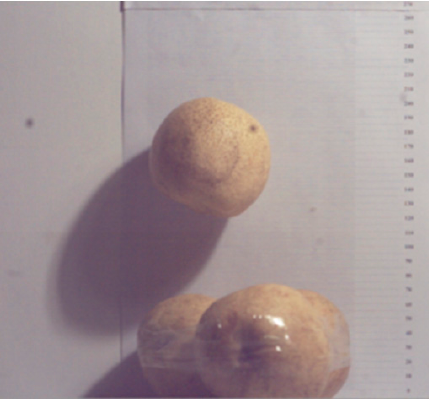
Figure 7. Calibration experiment of collision recovery coefficient between typical pears.